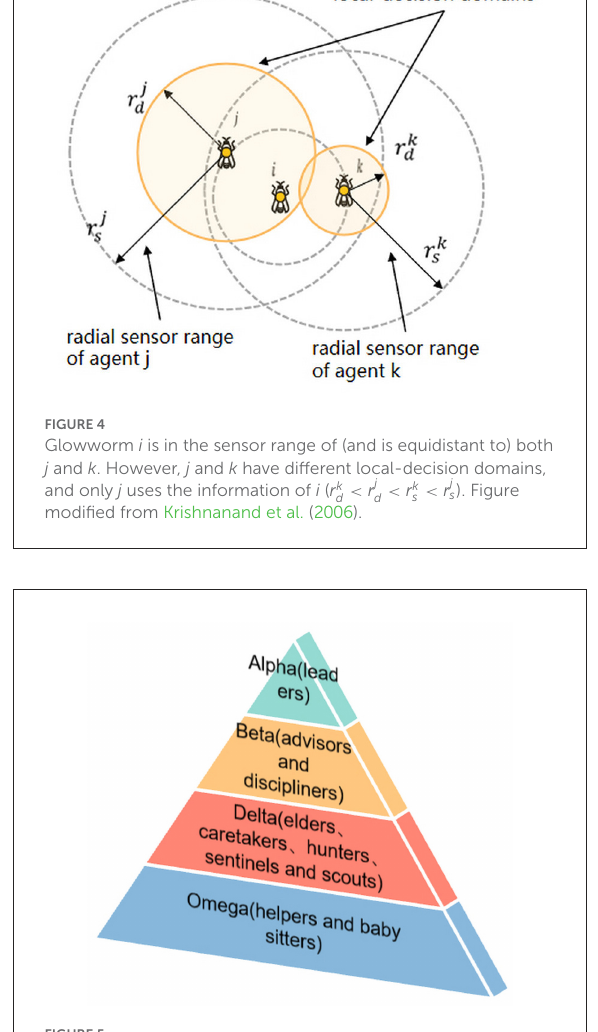
FIGURE5 Schematic diagram of the hierarchy of